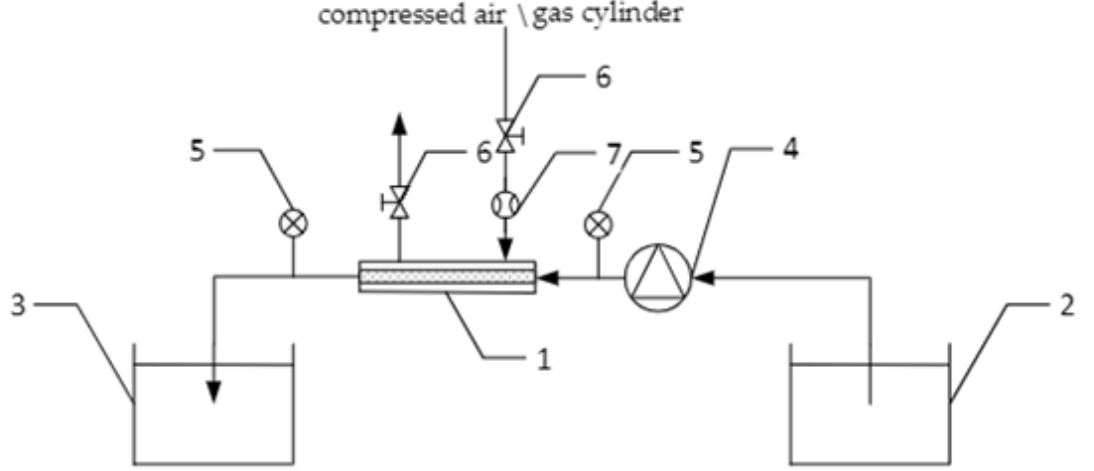
Figure 2. Scheme of the technological installation for the micro-nano bubble water generation: 1—micro-nano bubble generator with a ceramic membrane, 2—primary tank, 3—micro-nano bubble mixing water tank, 4—pump, 5—manometer, 6—valve, 7—rotameter [36].